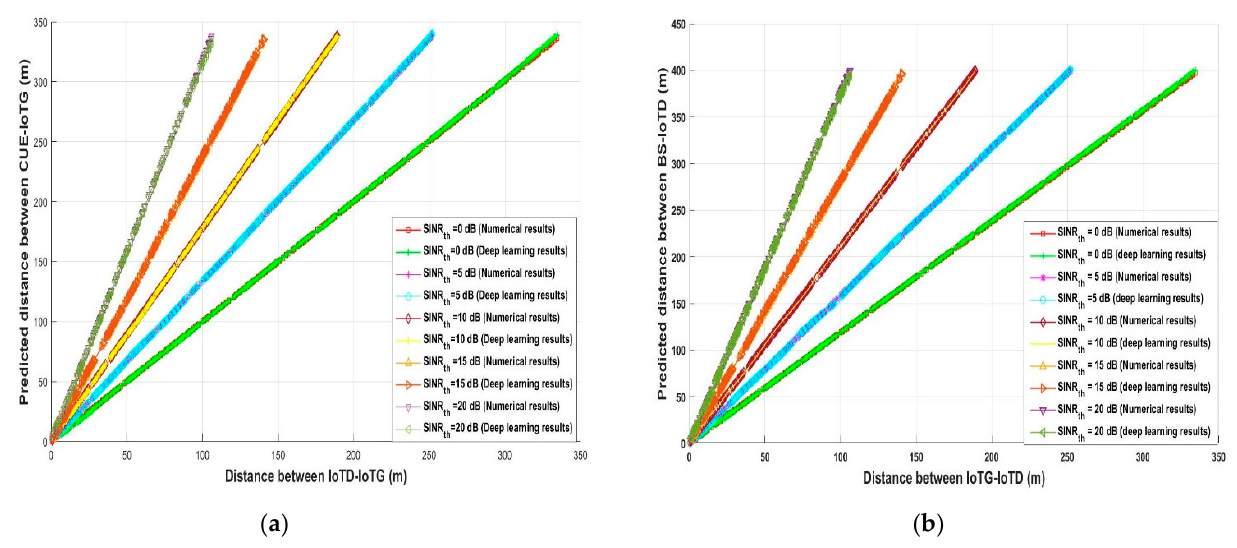
Figure 6. ( a ) Distance between IoTD-IoTG versus predicted distance between CUE-IoTG (uplink) ( b ) Distance between IoTG-IoTD versus predicted distance between BS-IoTD.